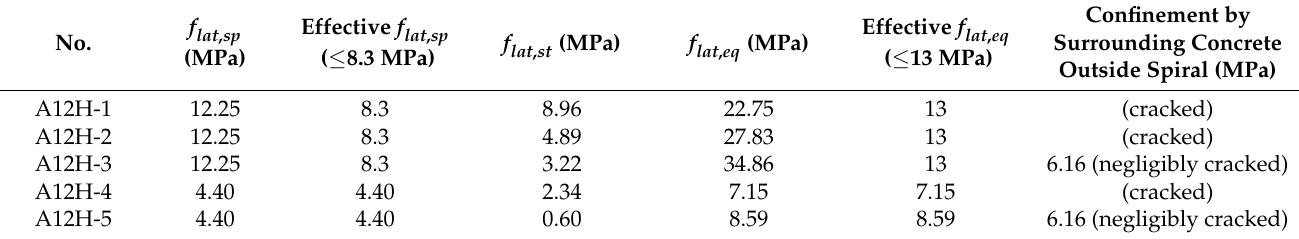
Table 2. Lateral confinement in group 1